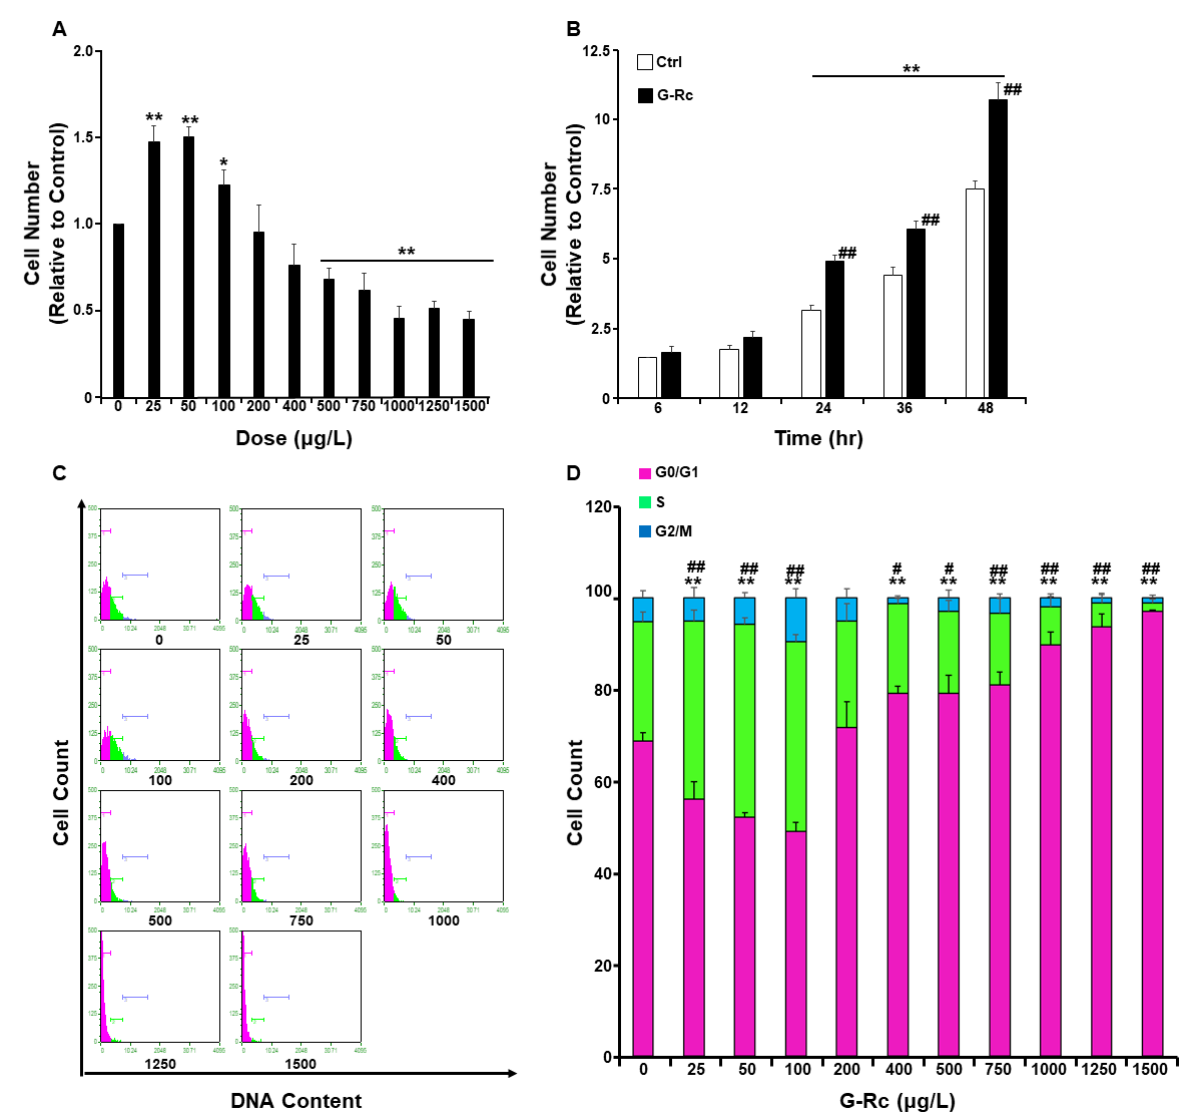
Figure 2. Effects of G−Rc on cell survival/toxicity, proliferation, and cell cycle. ( A ) Effects of G−Rc on cell survival using the MTT method. Undifferentiated UB/OC−2 cells were treated with increasing doses of G−Rc for 24 h. Bar graphs represent the intensity of formazan (produced from MTT by viable cells) staining reflective of the cell number and presented as means + SEM. ( B ) Effects of G−Rc on cell proliferation using the SRB method: cells were treated with G−Rc (25 μg/L) for up to 48 h. Bar graphs represent the intensity of SRB staining reflective of the cell number and presented as means + SEM. ( C ) Cell cycle analysis and assessment of DNA content in undifferentiated UB/OC−2 cells treated with the indicated concentration (0–1500 μg/L) of G−Rc for 24 h. A representative histogram for each treatment is shown. ( D ) Bar graphs represent the percentages of cells in each phase of the cell cycle, which were estimated using the GuavaSuite Software package, and are presented as means + SEM from three independent experiments. In ( A ), * p < 0.05 and ** p < 0.01 indicate a significant difference between the indicated concentration of G-Rc and control cells non-treated with G−Rc. In ( B ), ** p < 0.01 indicates a significant difference between the indicated time and control cells at 6 h post-seeding. ## p < 0.01 indicates a significant difference between G−Rc−treated cells and control cells non-treated with G−Rc. In ( D ), ** p < 0.01 indicates a significant difference in DNA content between G−Rc-treated cells and control cells non-treated with G−Rc while at the G0/G1 phase. # p < 0.05 and ## p < 0.01 indicate a significant difference in DNA content between G−Rc−treated cells and control cells non-treated with G−Rc while at S phases.